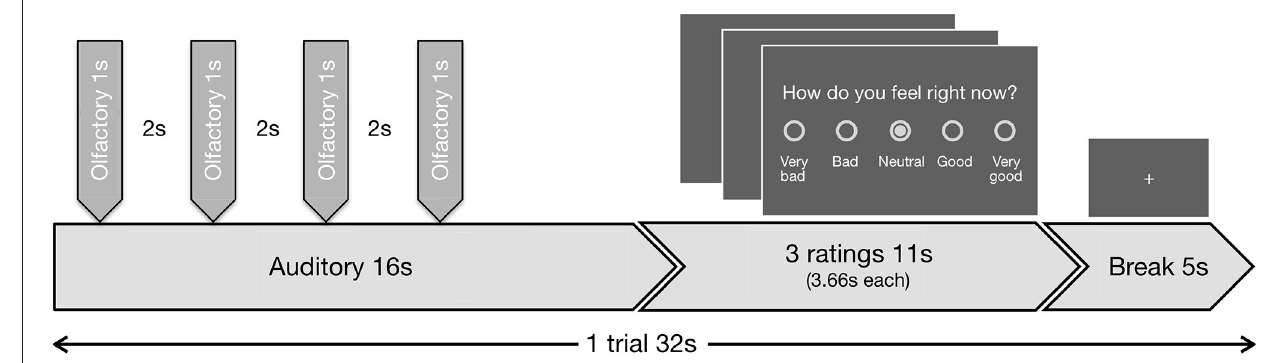
FIGURE 1 | Schematic visualization of the experimental design. Exemplary trial (duration 32s) out of 48 trials, presented in the fMRI task. Each trial began with the presentation of an auditory stimulus (duration 16s, first second fade-in, last second fade-out). Four olfactory stimuli (duration 1s each, interrupted by breaks of 2s) were administered during the continuing presentation of the auditory stimulus. All four of the olfactory stimuli were either negative or neutral. The first olfactory pulse was administered jittered at random with a delay of 1.0, 1.5, 2.0, or 2.5s relative to the beginning of the auditory stimulus, so always after the fade-in period was completed. The administration of the stimuli combination was followed by three ratings (duration 11s, 3.66s per rating) and a baseline period (duration 5s), where a fixation cross was